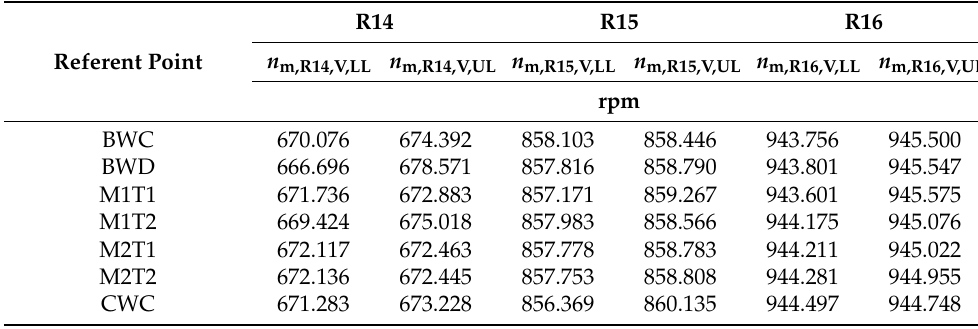
Table 13. Boundaries of the FREM resonant domains according to a V,per –EHO: 5.